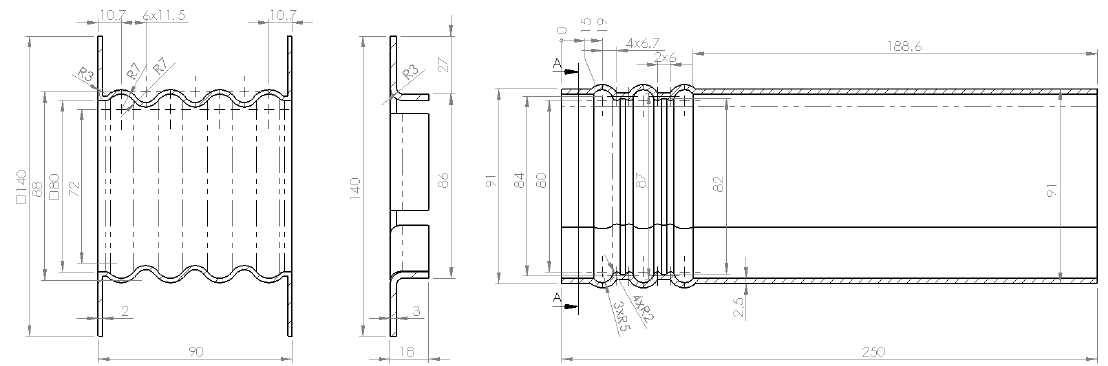
Figure 5. Side view of crash box, flange and frame rail.